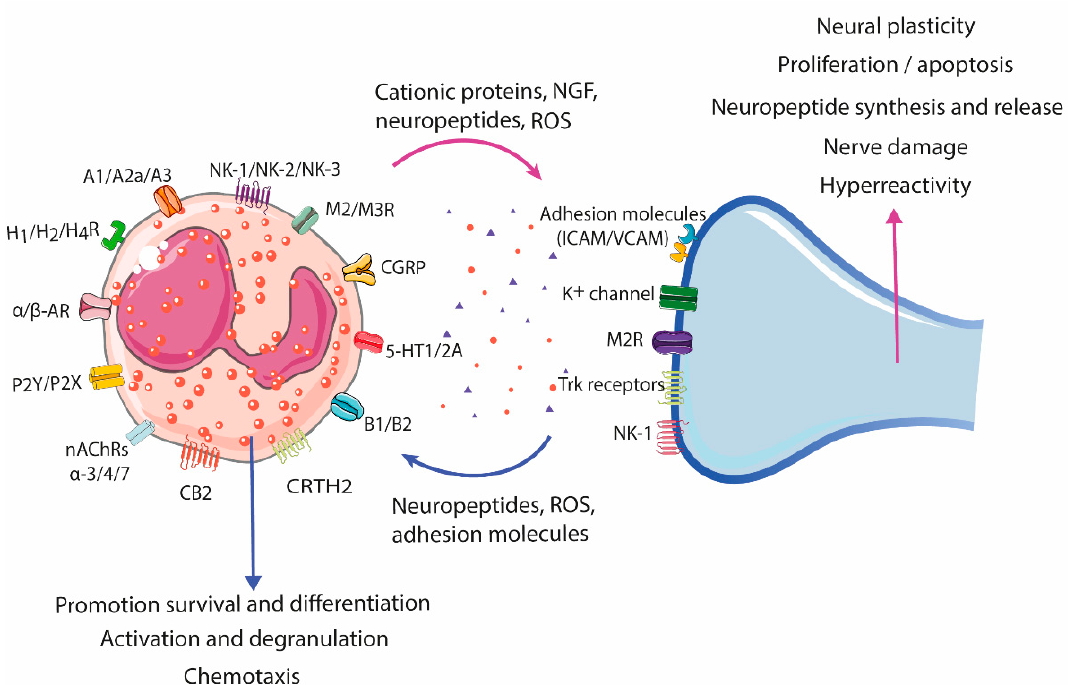
Figure 3. Eosinophil–neuron interaction. Eosinophils and neurons communicate bidirectionally, modulating functions in both cell types. Nerve cells can recruit eosinophils through the release of neuropeptides, cytokines, and chemokines, and activate degranulation through nerve contact facilitated by adhesion molecules (intercellular and neural cell adhesion molecules (ICAMs and NCAMs). The release of bioactive mediators by eosinophils, such as cationic proteins, ROS, and neuropeptides/neurotrophines, results in a variety of neuronal effects, including nerve growth, nerve damage, neuropeptide synthesis and release, and activation and sensitization, leading to hyperreactivity and aberrant neuropeptide release in pathological conditions. A1/A2a/A3, Adenosine receptor; AR, Adrenergic receptor; B1/B2, Bradykinin receptor; CB2, Cannabinoid receptor 2; CGRP, Calci- tonin gene-related peptide; CRTH2, Chemoattractant receptor-homologous molecule expressed on Th2 cells; H1/H2/H4R, Histamine receptor H1, H2, H4; ICAM, Intercellular cell adhesion molecule; M2/M3R, Muscarinic receptor 2, 3; nAChRs α -3/- α 4/ α -7, Nicotinic acetylcholine receptor α -3, - α 4, and α -7; NK-1/NK-2/NK-3, Tachykinin receptor 1, 2, 3; P2Y/P2X, Purinergic receptor 2Y, X;